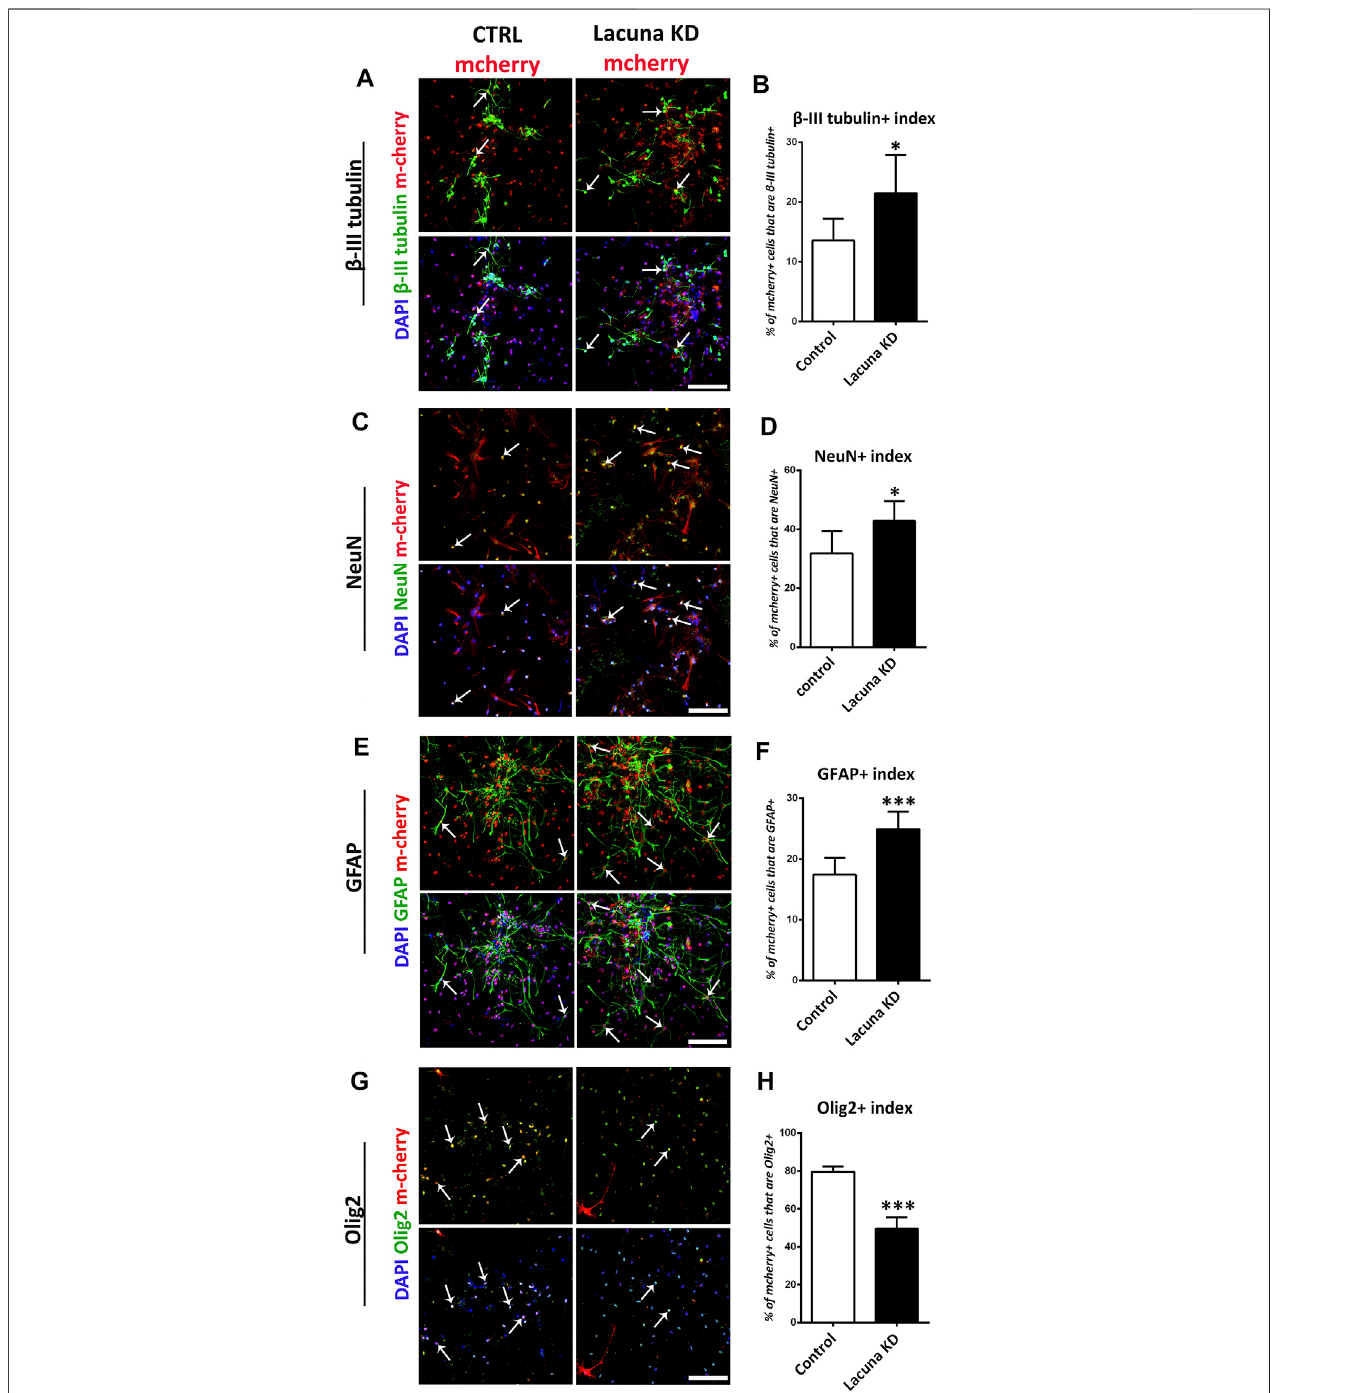
FIGURE 5 | Lacuna knockdown promotes differentiation of mouse Neural Stem Cells. (A) Mouse Neural Stem cells were transfected with dCas9-KRAB-mcherry and sgRNA1 targeting Lacuna ( Lacuna KD-mcherry)orno guideRNA(CTRL-mcherry). Theywereimmunostained for β -III tubulin(green), mcherry (red) and labeled with DAPI. Scale bar: 100 μ m. (B) Quanti fi cation of β -III tubulin positive cells in dCas9-KRAB-mcherry positive mouse Neural Stem cells (Control: 13.54 ± 1.481%, Lacuna KD: 21.50 ± 2.617%, p < 0.05, N (cid:2) 6 independent experiments, in total 1,047 cells for Control condition and 1,438 cells for Lacuna condition). (C) Mouse Neural Stem cells were transfected with dCas9-KRAB-mcherry and sgRNA1 targeting Lacuna ( Lacuna KD-mcherry) or no guide RNA (CTRL-mcherry). They were immunostained for NeuN (green), mcherry (red) and labeled with DAPI. Scale bar: 100 μ m. (D) Quanti fi cation of NeuN positive cells in dCas9-KRAB-mcherry positive mouse Neural Stem cells (Control: 31.86 ± 3.062%, Lacuna KD: 42.86 ± 2.723, p < 0.05, N (cid:2) 6 independent experiments, in total 89 cells for Control condition and 81